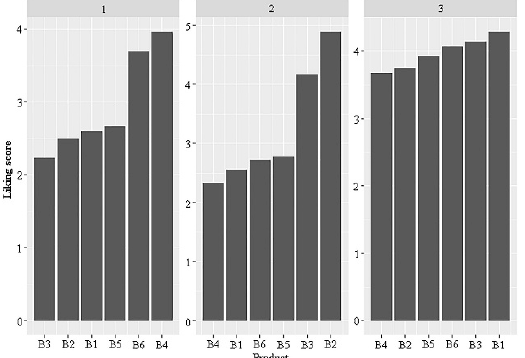
Figure 6. The bar plot of average liking scores by three clusters of consumers for products (n = 30 for cluster 1, n = 18 for cluster 2 and n = 28 for cluster 3). The vinegar code corresponds with Table 1.